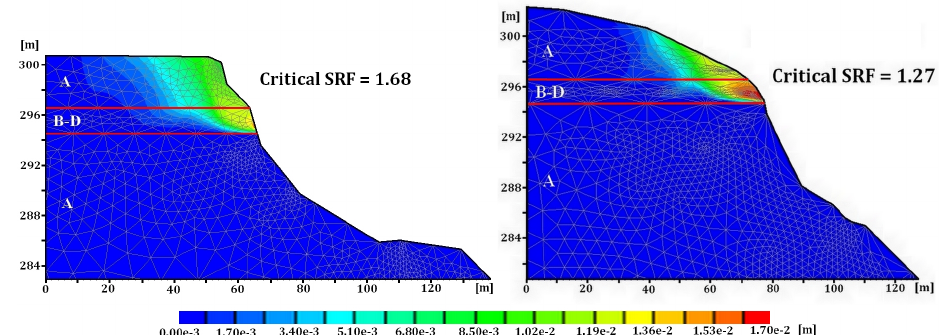
Figure 10. The results of the global stability analysis of the slopes (sections 3 and 4 in Fig. 3). Total displacements are marked from blue to red (lithology is indicated by letters A–D; note the weak zone marked by B–D; description of lithologies is given in Fig. 8.)